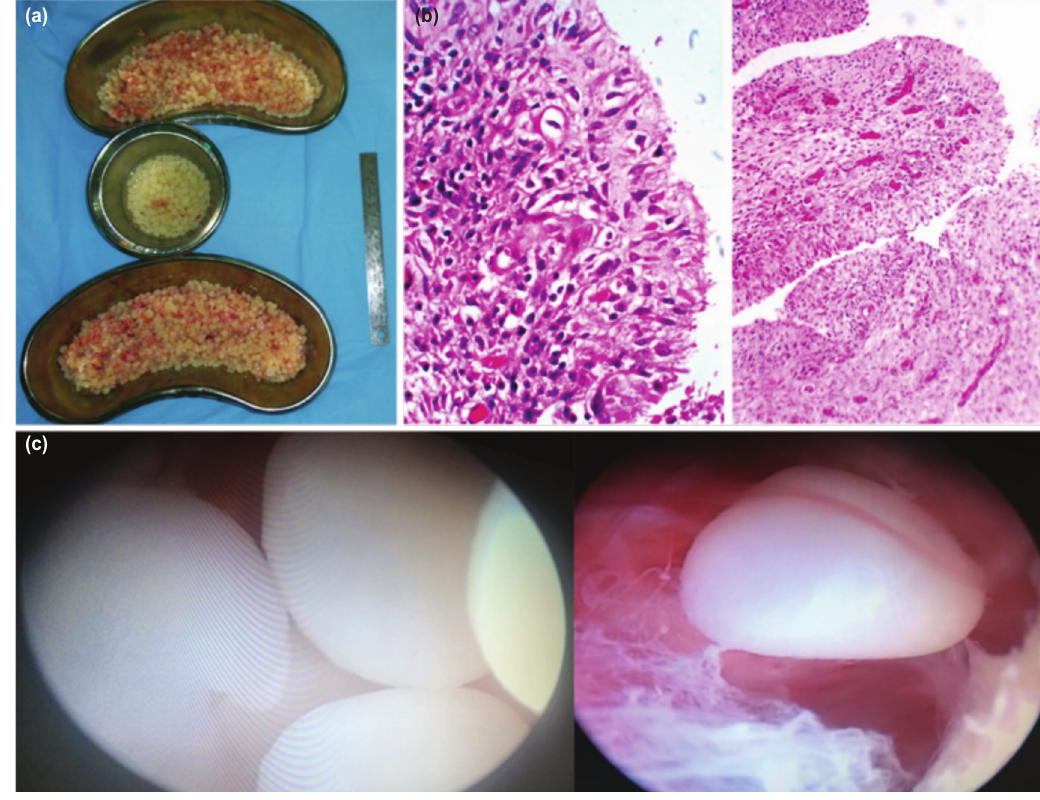
(a) Rice bodies-gross specimen. (b) Rice bodies-microscopic histology consisting of dense fibrin deposition with fibroblast and Fig. 3: mono nuclear cells (Hematoxylin-eosin stain, magnification × 200 & x 10). (c) Arthroscopic image of multiple rice bodies in sub- deltoid